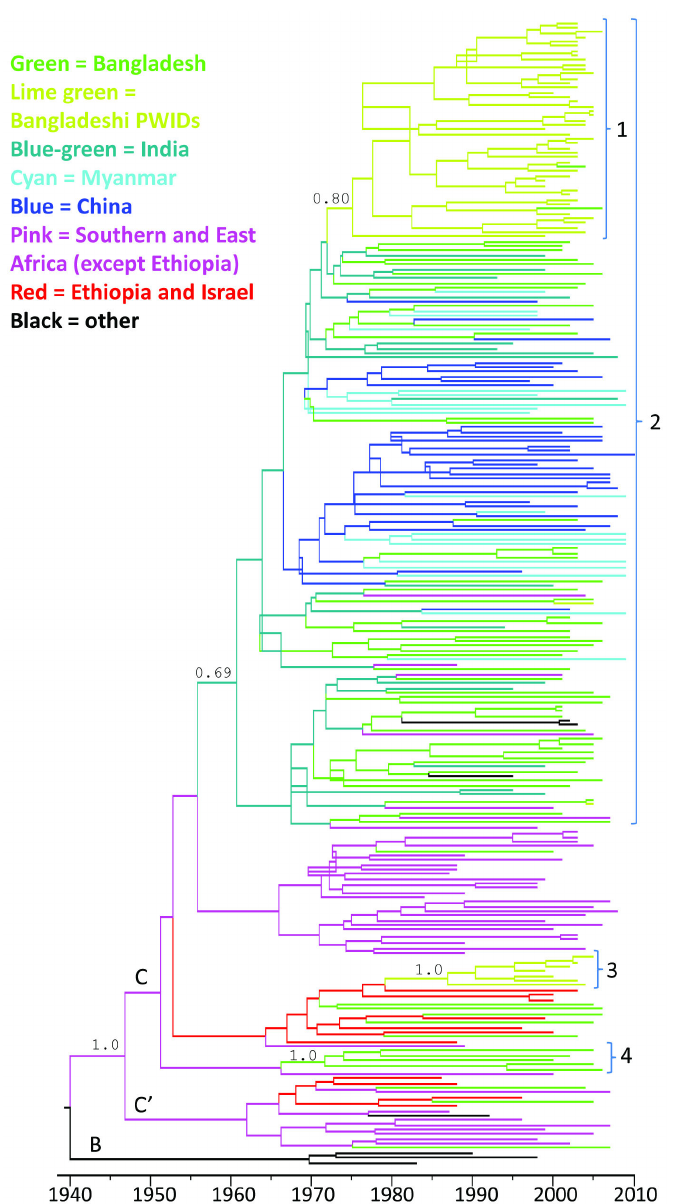
Figure 1. Phylogenetic tree of 246 gag -sequences, including 118 Bangladeshi HIV-1 C strains in green. The HIV1-C strains found in Bangladesh do not fall into a country specific clade, instead our results point to repeated introductions with substantial in- country transmission only among PWIDs. Four clades with ≥3 BD strains had a posterior probability of around 0.7 or higher, and are shown in the figure. Clade 1 is a monophyletic clade of 47 BD strains, of which 43 originate from PWIDs in Dhaka. The tMRCA of this clade is around 1975. It is a subset of the large regional Clade 2 , which is dominated by strains from Bangladesh, Myanmar, India and China. Over 80% of all BD strains can be found within this clade, which appears to have been introduced to this region around 1962. The intermixing of sequences collected from different countries indicates frequent cross-border transmission in this region. In addition to the 47 strains in Clade 1, the BD strains in Clade 2 includes sequences from returning migrants from Nepal, India and the Middle East as well as some weakly supported clades of strains from sex workers and VCT/STI patients. Clade 3 consists of seven PWID strains from Dhaka, and the short branches in this clade reveal rapid transmission (and detection) within this group. Clade 4 contains five strains from VCT visitors in Dhaka and Chittagong, at least 3 of whom had a history of migrant work in the Middle East. The long branches show that they are not very close genetically and it is possible that they represent separate introductions of related strains. Most of the BD strains found outside these clades appear to represent separate introductions. doi: